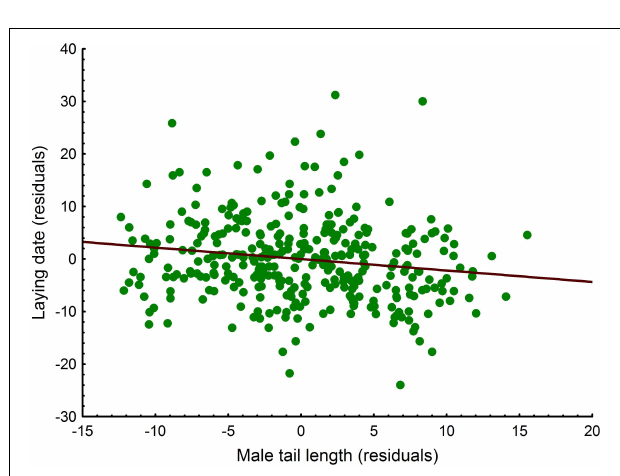
FIGURE 9 | Linear relationship between laying date (residuals) and tail length in male common